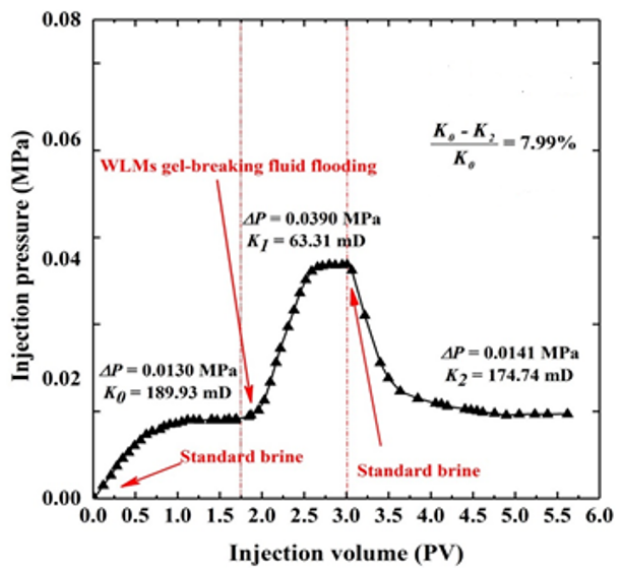
Figure 17. The effect of temperature and alternate shear rate time on the apparent viscosity of VES fluids at shear rate of 170 (s − 1